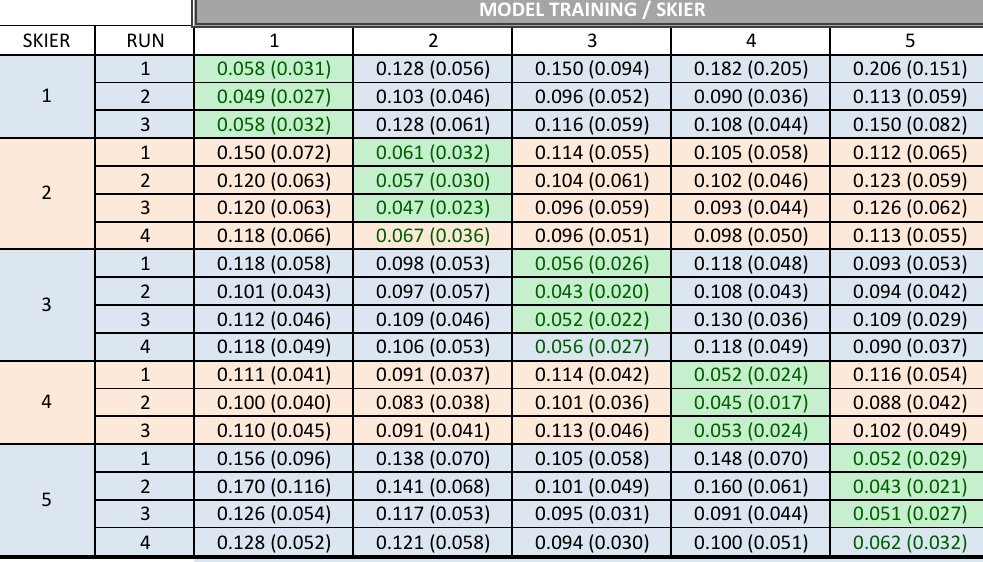
Table 2. Cross-validation of NN models. Models were learned using all runs of the same skier (columns). Mean errors and standard deviations of the positions of the skis for these models were calculated for all 18 runs. All values in the table are given in